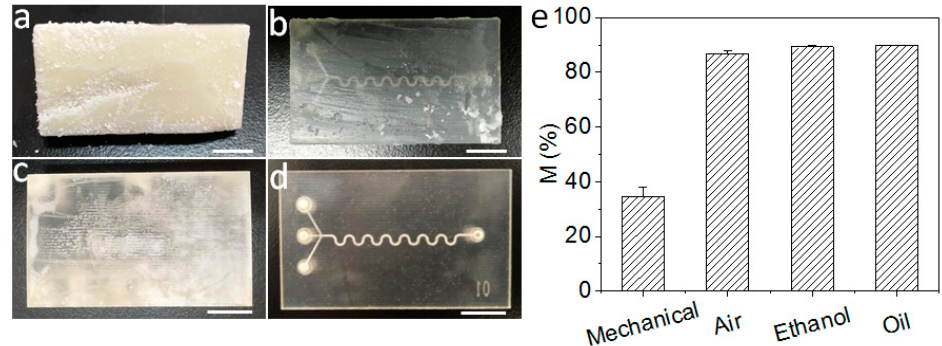
Figure 2. Four approaches to removing outer sacrificial materials. ( a ) Mechanical removing, ( b ) Removing outer sacrificial materials in a hot oven, ( c ) 95% hot ethanol, ( d ) hot vegetable oil, and ( e ) Mass reductions with the four approaches. The scale bar is 1 cm.